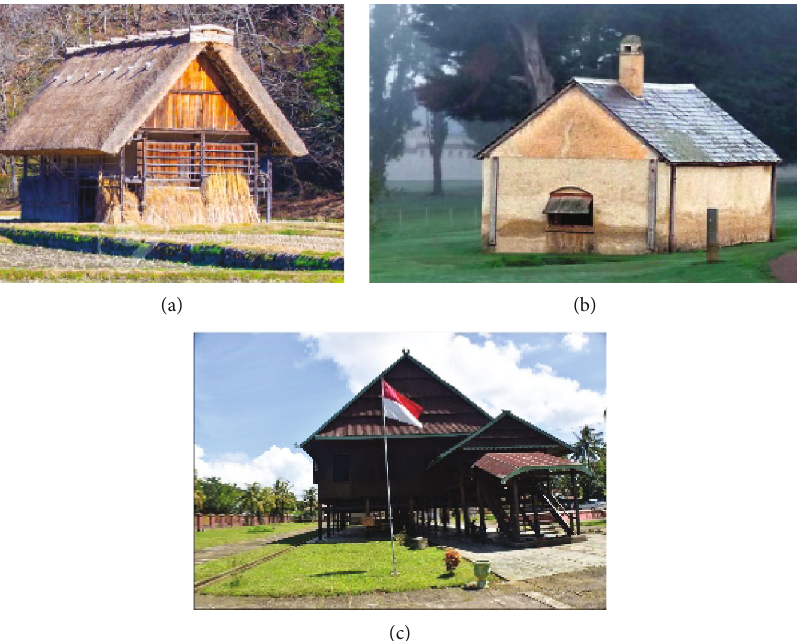
Figure 28: (a) Gassho Zukuri Style, Japan [7, 13] (b) An Old house in Tazmania, Australia, (c) Bola Soba, Indonesia [10].